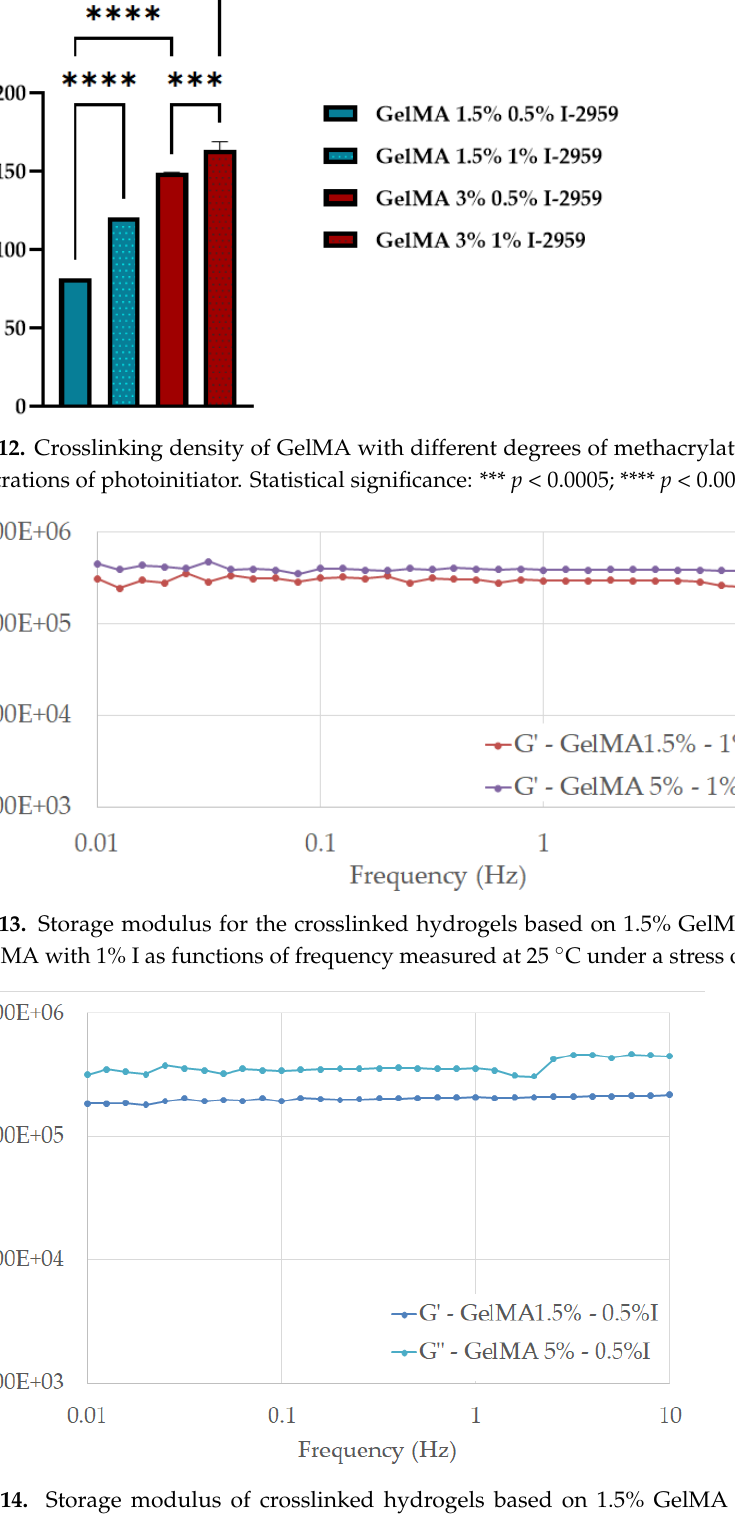
Figure 14. Storage modulus of crosslinked hydrogels based on 1.5% GelMA with 0.5% I and 5% GelMA with 0.5% I as functions of frequency measured at 25 °C under a stress of 5 Pa.